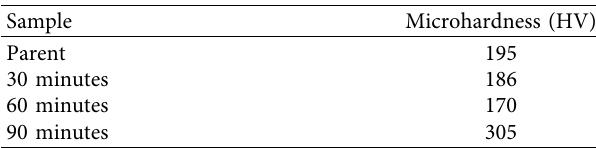
Figure 7: Measured microhardness point graph of different samples: (a) parent, (b) 30min, (c) 60min, and (d) 90 min. Table 5: Average microhardness